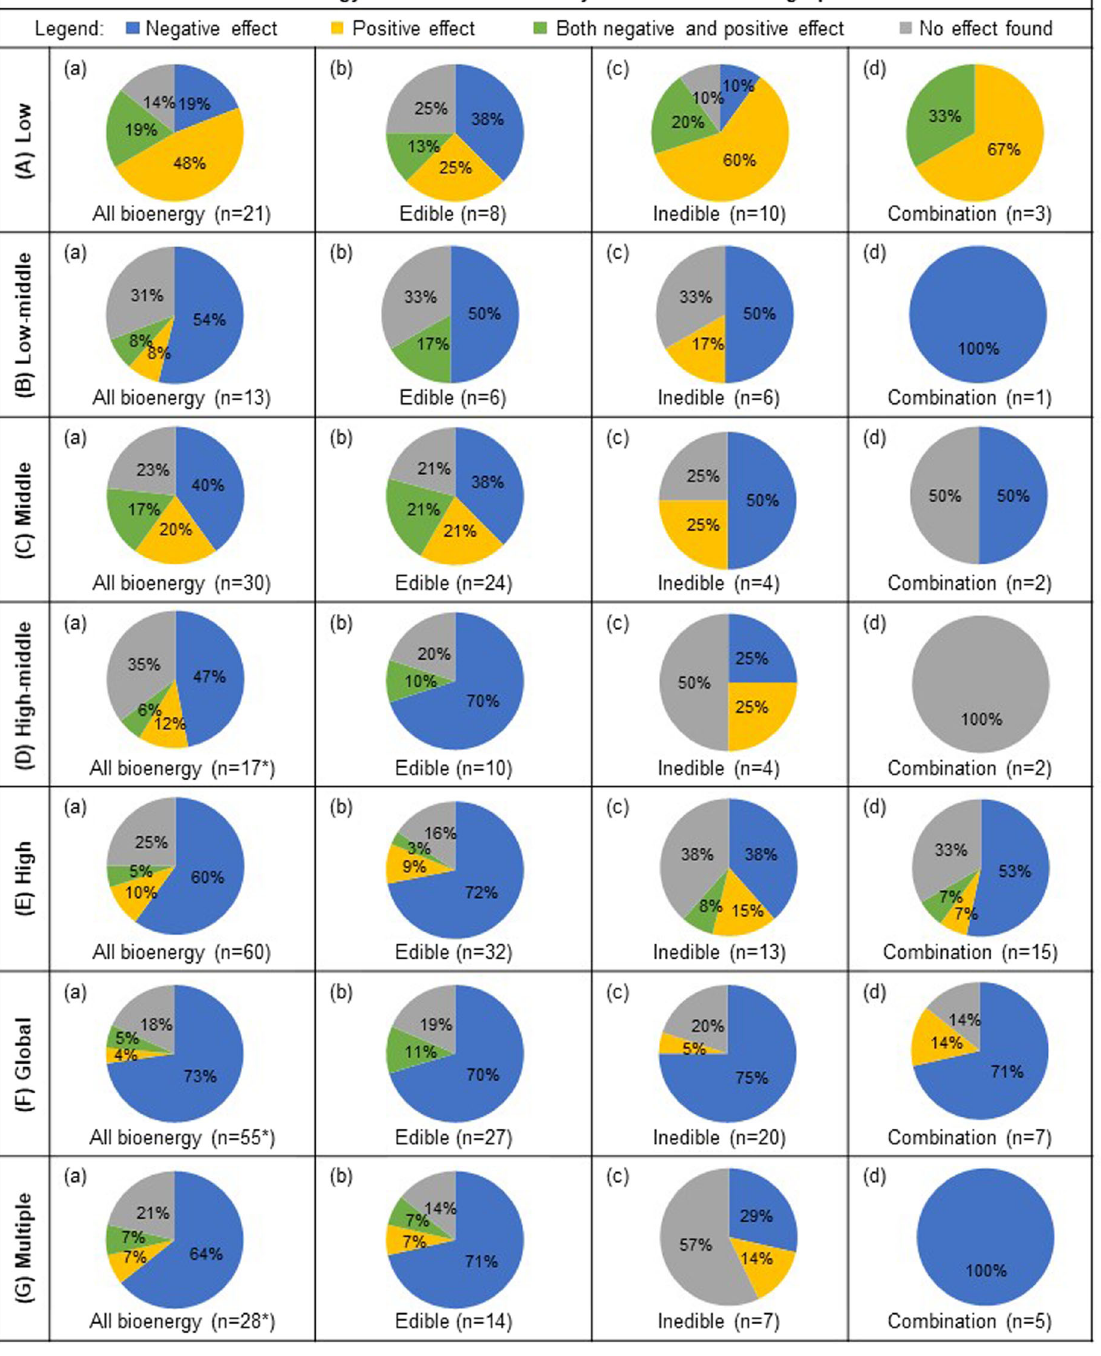
Fig. 4 Effects of bioenergy on food security across sociodemographic index. The percentage of reviewed publications ( n = 224) that reported either negative, positive, both negative and positive, or neutral effect of all bioenergy (column a ), edible ( b ), inedible ( c ), and studies that included a combination of both edible and inedible feedstocks in their analysis (d) in countries with an SDI Index level (row A ) low, ( B ) low-middle, ( C ) middle, ( D ) high-middle, ( E ) high, ( F ) global studies (all SDI levels), and ( G ) studies that included multiple SDI ’ s. *Bioenergy type “ not speci fi ed ” ( n = 4) is only included in “ All bioenergy ” (column a ), and therefore the sum of edible, inedible, and both edible and inedible feedstocks (columns b – d ) will not necessarily be a composite of “ All bioenergy ”